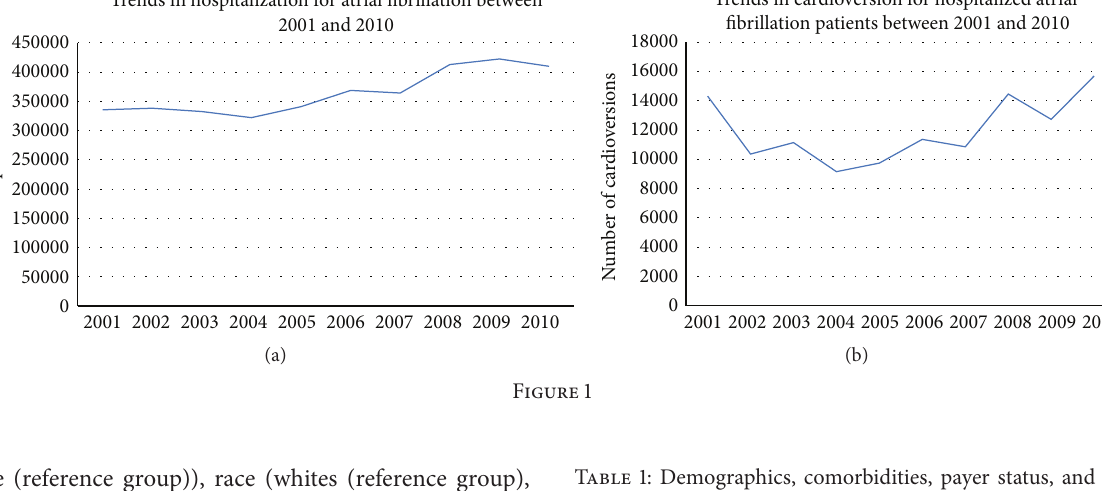
Table 1: Demographics, comorbidities, payer status, and hospital data for patients hospitalized for atrial